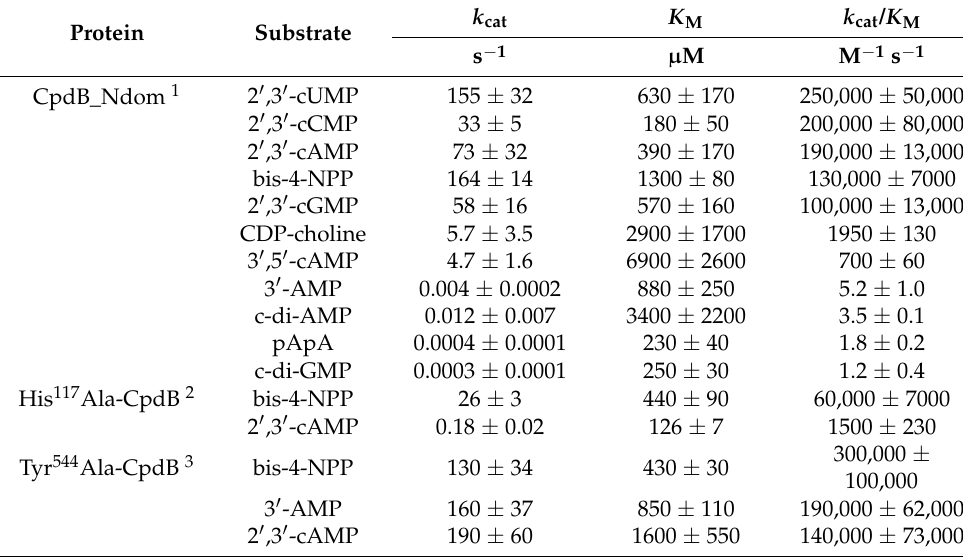
Table 1. Kinetic parameters of the N-terminal domain of CpdB (CpdB_Ndom) and point mutants of mature CpdB. Results are expressed as mean values ± standard deviations of three independent